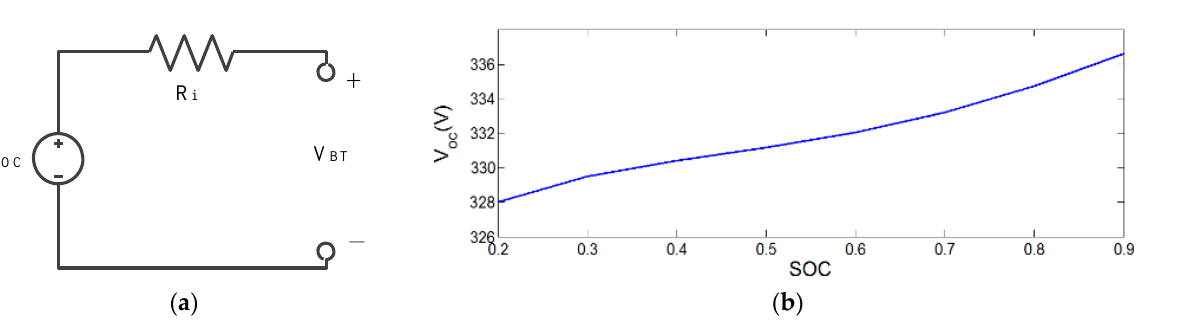
Figure 4. Model of the battery pack. ( a ) The battery diagram of the equivalent circuit. ( b ) The correlation between the battery open-circuit voltage and SOC .